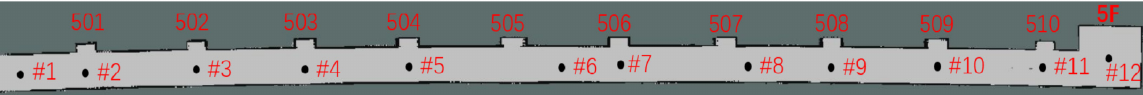
Figure 9. Occupancy grid map of the experimental environment.